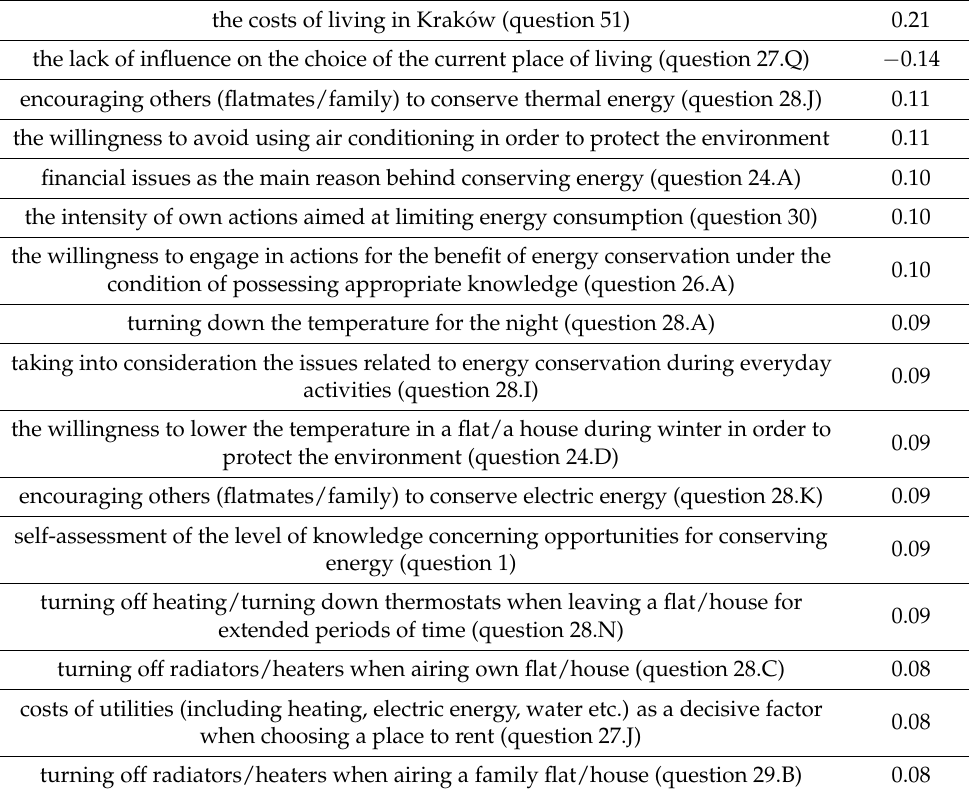
Table 1. Kendall’s Tau-b coefficients between energy poverty and other characteristics. the costs of living in Krak ó w (question 51) 0.21 the lack of influence on the choice of the current place of living (question 27.Q) −